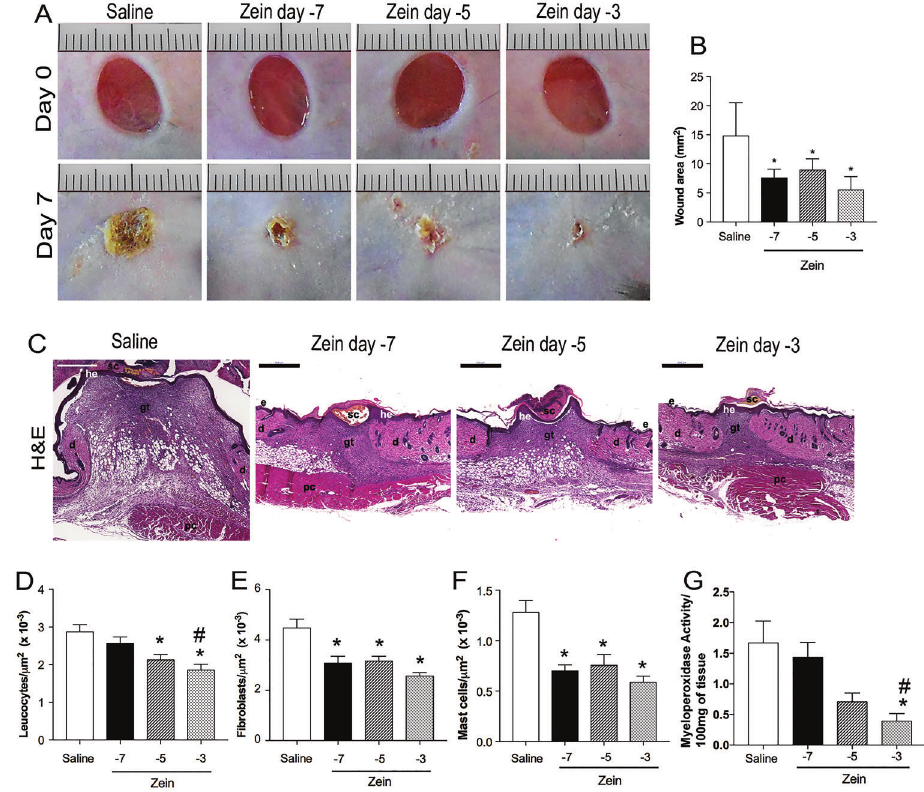
Figure 4. Subcutaneous injection of zein before skin injury reduced the in fl ammatory in fi ltrate and accelerated wound closure and scab drop. A , Macroscopic photographs of wounds immediately after skin injury (33 mm 2 ) and 7 days after injury in mice injected with saline or zein plus adjuvant. B , Wound area 7 days after skin injury in mice injected with saline or zein + adjuvant at 7, 5, or 3 days before wounds. Data are reported as means ± SE (n=6 mice, 12 wounds). *P p 0.05 compared with the saline group. C , Representative images of skin at day 7 after injury in the control mice (saline) and mice injected with zein at 7, 5, or 3 days before skin injury (H&E-stained sections). e, epidermis; d, dermis; gt, granulation tissue; he, hypertrophic epidermis; pc, panniculus carnosus; sc, scab. Scale bars: 500 m m. D – F , Morphometric analyses of leukocytes, fi broblasts, and mast cells. G , Quanti fi cation of myeloperoxidase activity. Control mice and mice injected with zein at 7, 5, or 3 days before injury. Data are reported as means ± SE (n=6). *P p 0.05 compared with the saline group, # P p 0.05 compared with the zein – 7 group